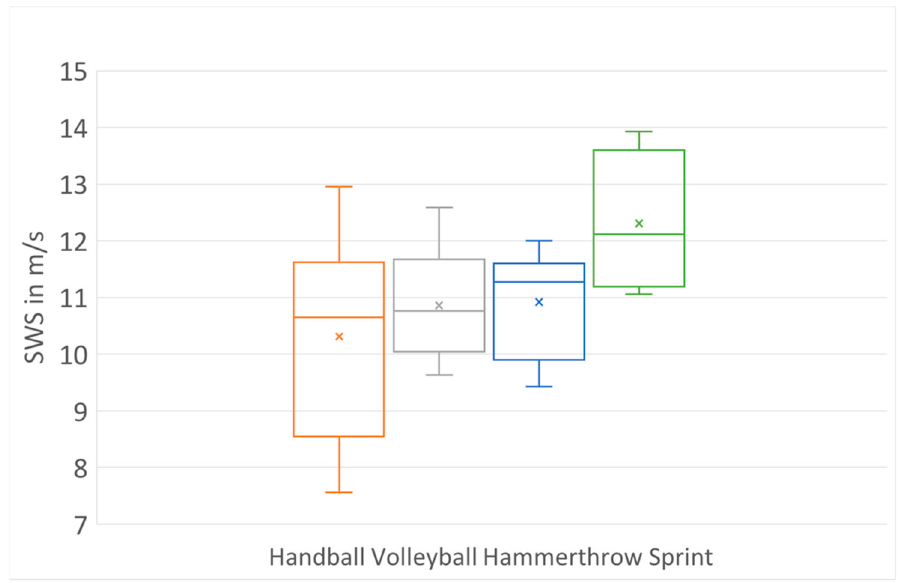
Figure 4. AT sti ff ness values for female athletes in di ff erent sports. Figure 4. AT stiffness values for female athletes in different sports.